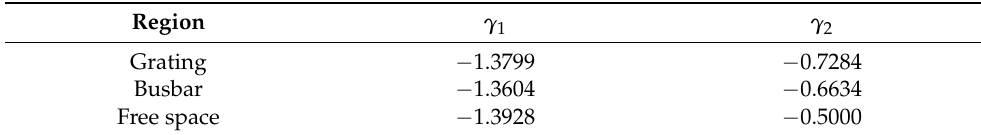
Table 1. Anisotropic parameters γ 1 and γ 2 of each region.